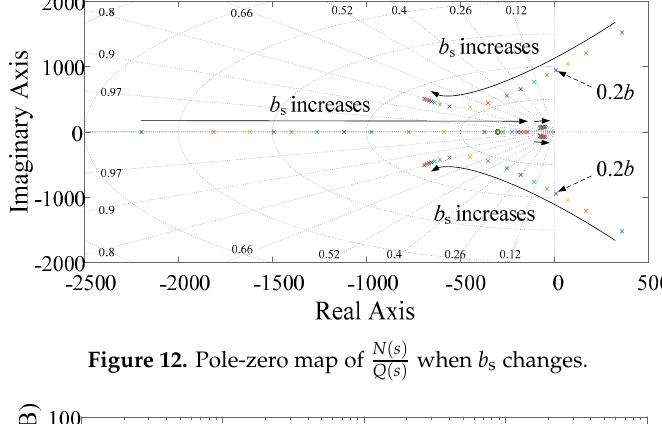
Figure 12. Pole-zero map of N